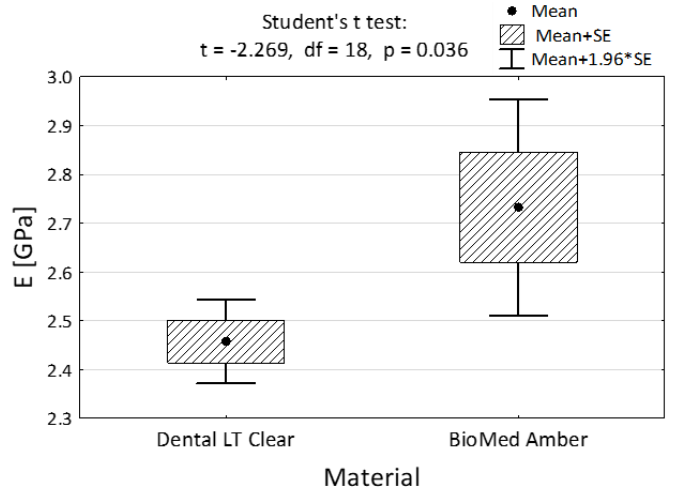
Figure 5. Compressive modulus of the two dental materials and the result of the Student’s t -test.